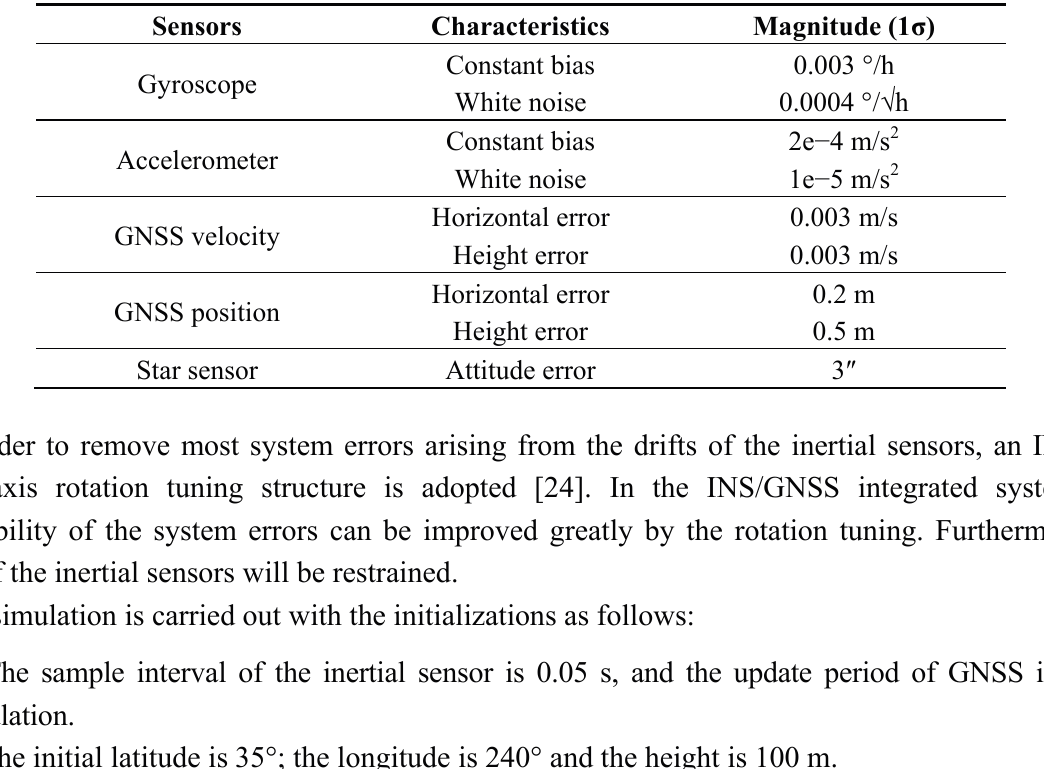
Table 1. The performances of sensors for